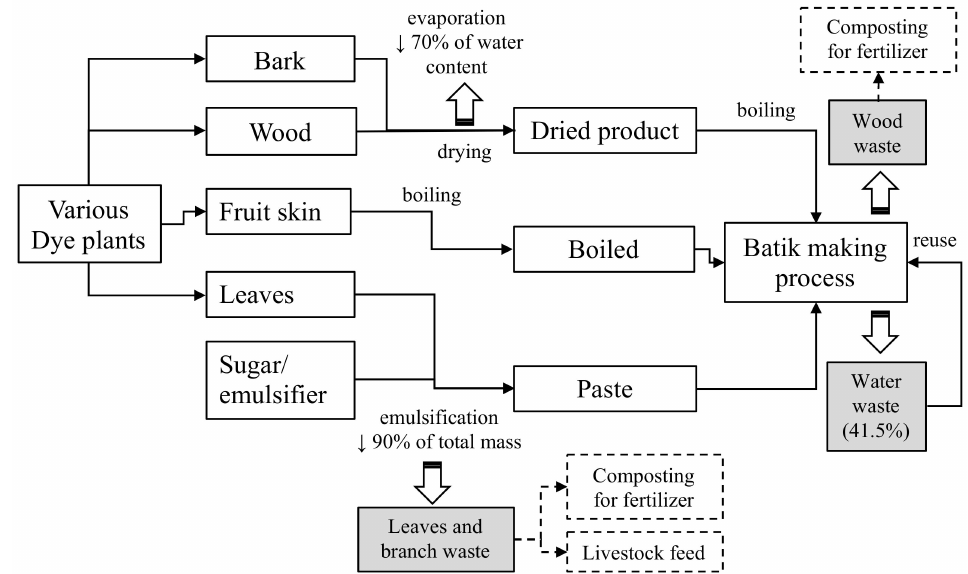
Figure 3. Natural dye-producing process and waste management during the coloring stages of the cleaner batik production method implemented by the Zie Batik SME. Table 2. Dye plant sources and waste